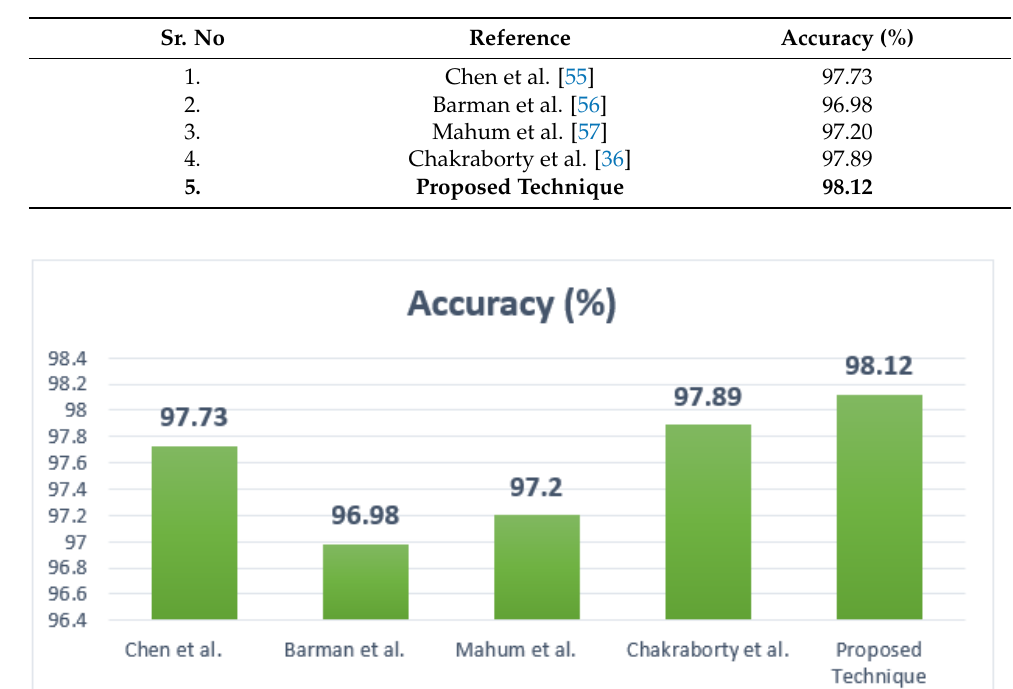
Table 5. Comparison of the proposed approach with new methods.